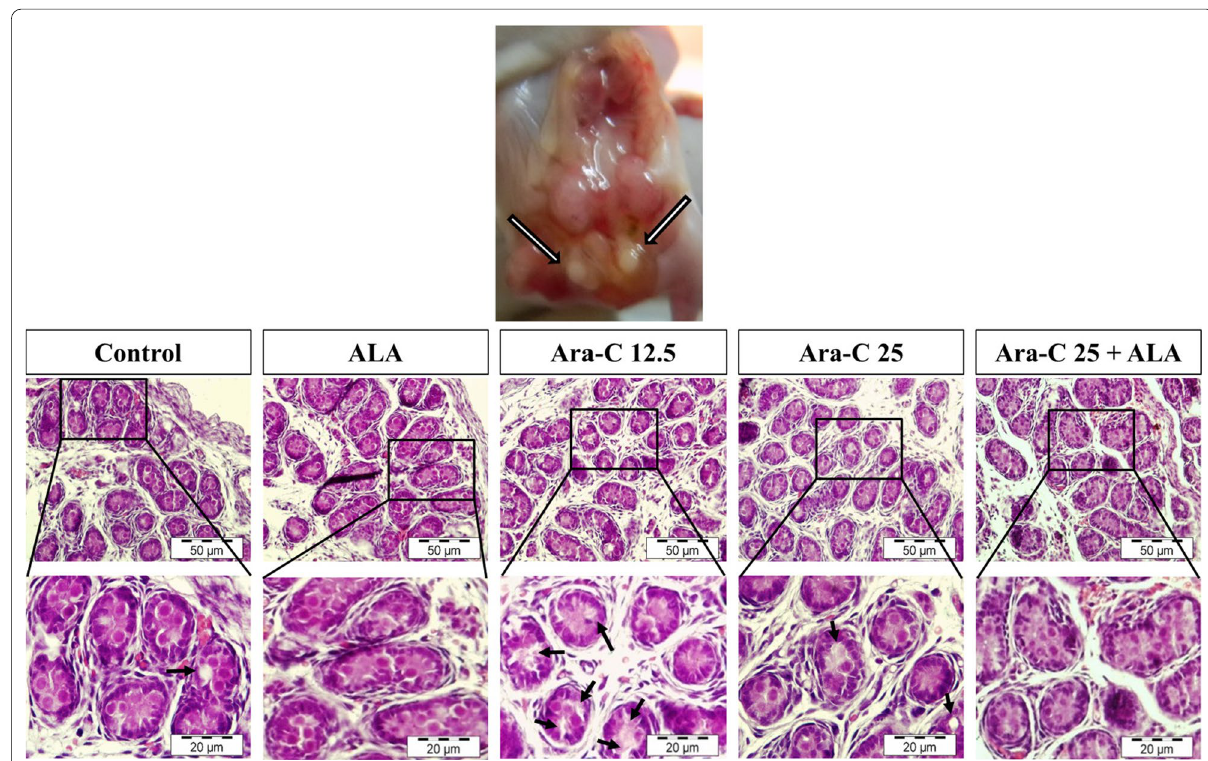
Fig. 6 Effect of Ara-C and ALA on fetal testicular histology. Representative photomicrographs of testes of rat fetuses. White arrows indicate the testes of the rat fetus. Black arrows indicate the areas of vacuolization. ALA alpha-lipoic acid 200 mg/kg, Ara-C